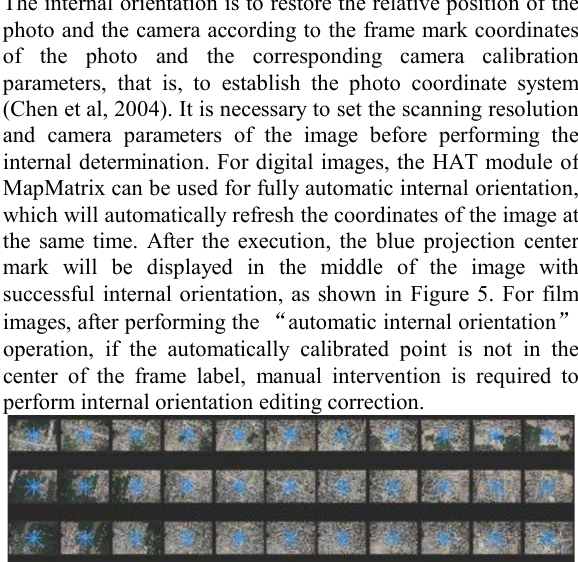
Figure 3. Dual image stereo mapping principle